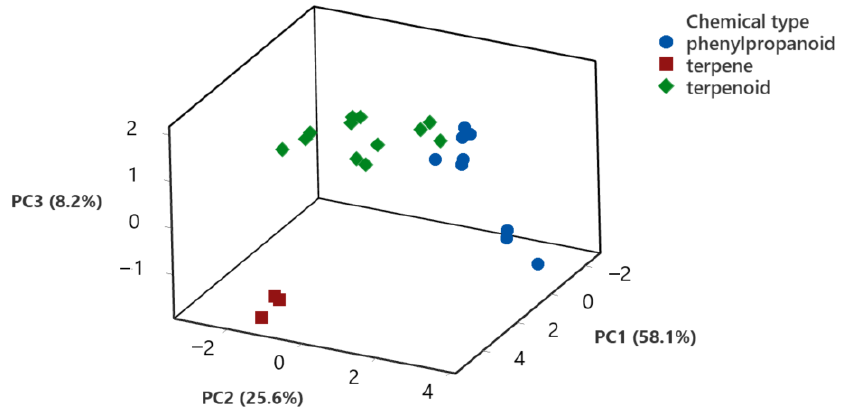
Figure 5. Principal Component Analysis (PCA) for the biological activity of major components of EOs against the different microorganisms analyzed. Scores for each chemical compound identified by their chemical structure for the first three PCA are shown.